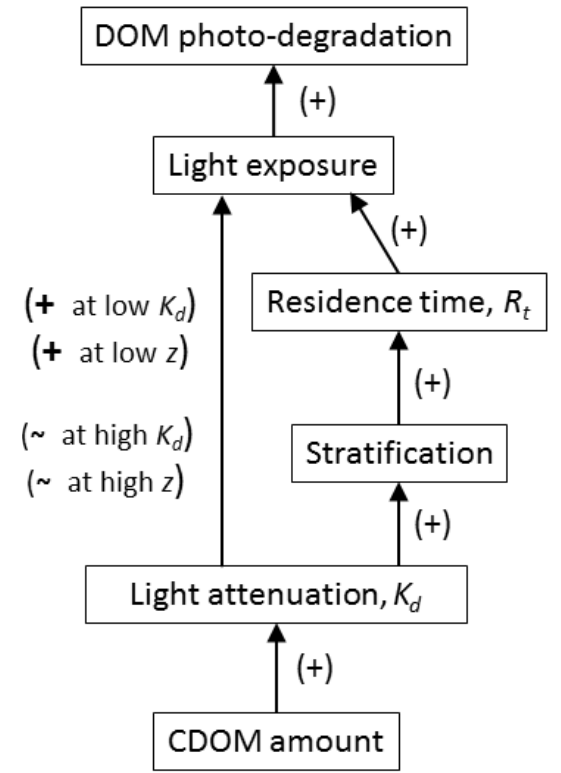
Figure 6. Conceptual diagram illustrating the controls on DOM photo-degradation. As CDOM increases it absorbs more light at the surface and strengthens stratification, which increases residence times, length of light exposure, and thus DOC photo-degradation (right side). Similarly, as CDOM and thus light attenuation increase the total amount of light exposure and light absorption increases in situations where there is low K d or shallow water column depth z . However, as K d or shallow water column depth increase the system becomes light-limited, and further increases in CDOM result in no change in DOM photo-degradation (asymptote of Fig.